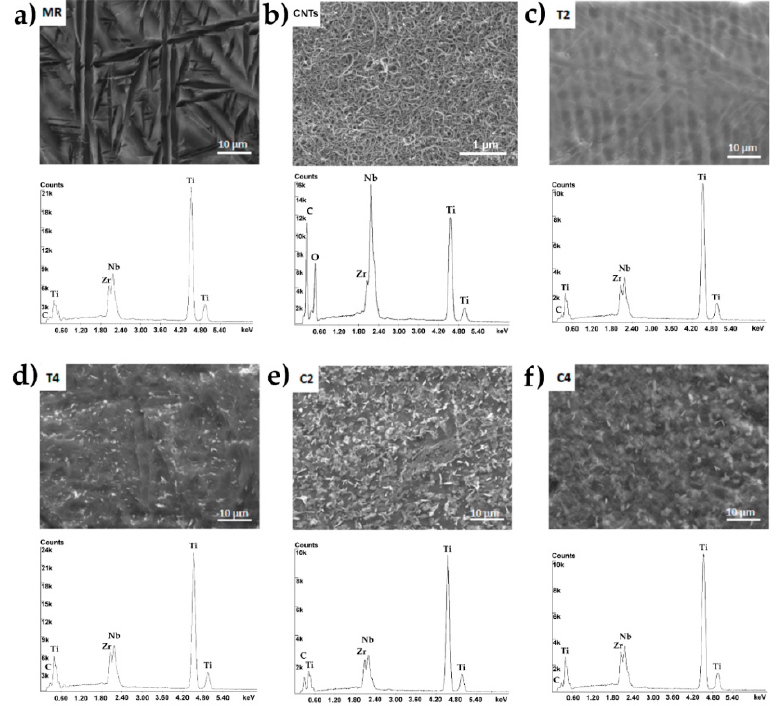
Figure 7. EDS spectra of Ti13Nb13Zr alloy: ( a ) MR, ( b ) MR with MWCNTs coating, ( c , d ) T2, T4—its alloys after laser treatment, ( e , f ) C2, C4—its alloys with MWCNTs coating after laser treatment with the shallowest penetration.